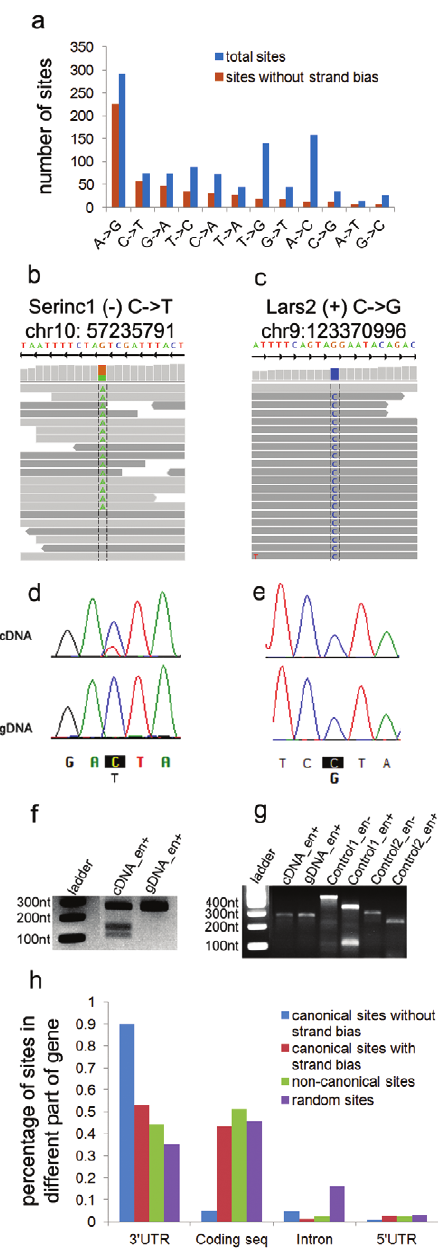
Figure 1. Distribution and validation of editing sites observed in RNA-seq data. A) Distribution of RNA editing types with and without a filter for significant strand bias from RNA-seq data. B,C) RNA- seq traces are shown for one canonical RNA editing site (C-to-U in Serinc1 ) and for one non-canonical editing site (G-to-C in Lars2 ). Reads sequenced in the sense direction are shown in dark grey, while reads sequenced in the reverse direction are shown in light grey. D,E) Sanger sequencing validation results for sites in Serinc1 and Lars2 . F,G) RFLP validation of sites in Serinc1 and Lars2 . Samples exposed to enzyme are labeled ‘‘en + ’’ and control samples are labeled ‘‘en-.’’ H) Genomic distribution of editing sites and random background.